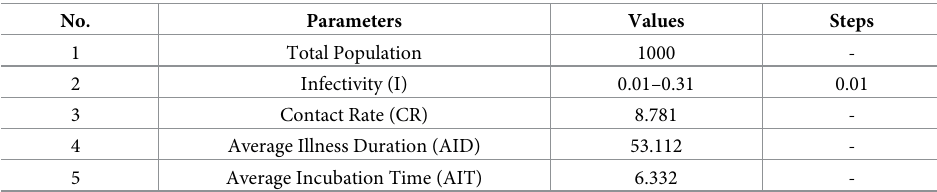
Table 4. Parameter values in the sensitivity analyses